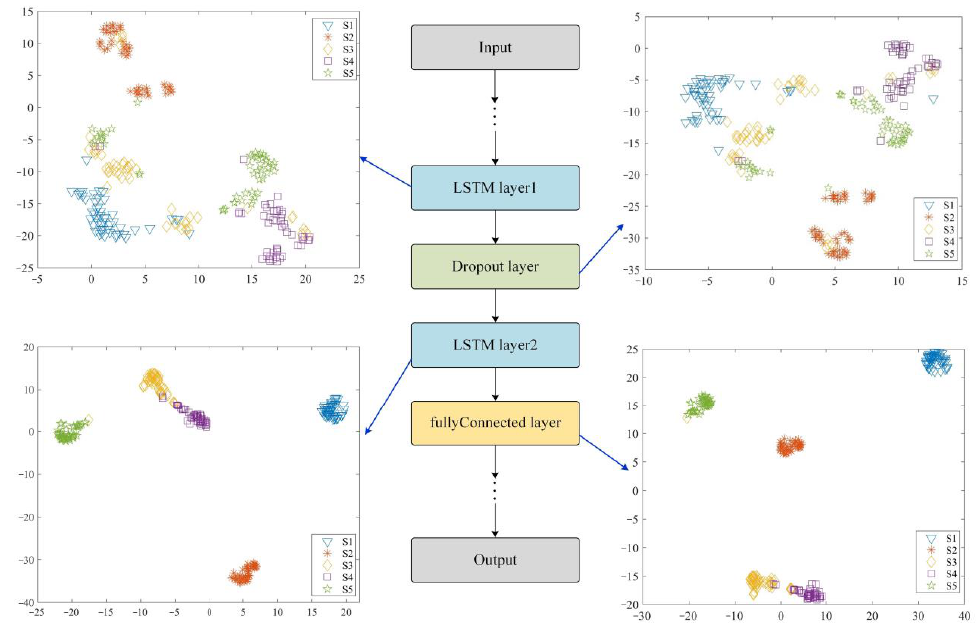
Figure 13. The t−SNE visualization analysis of the VMMFCC − LSTM network for feature extraction.